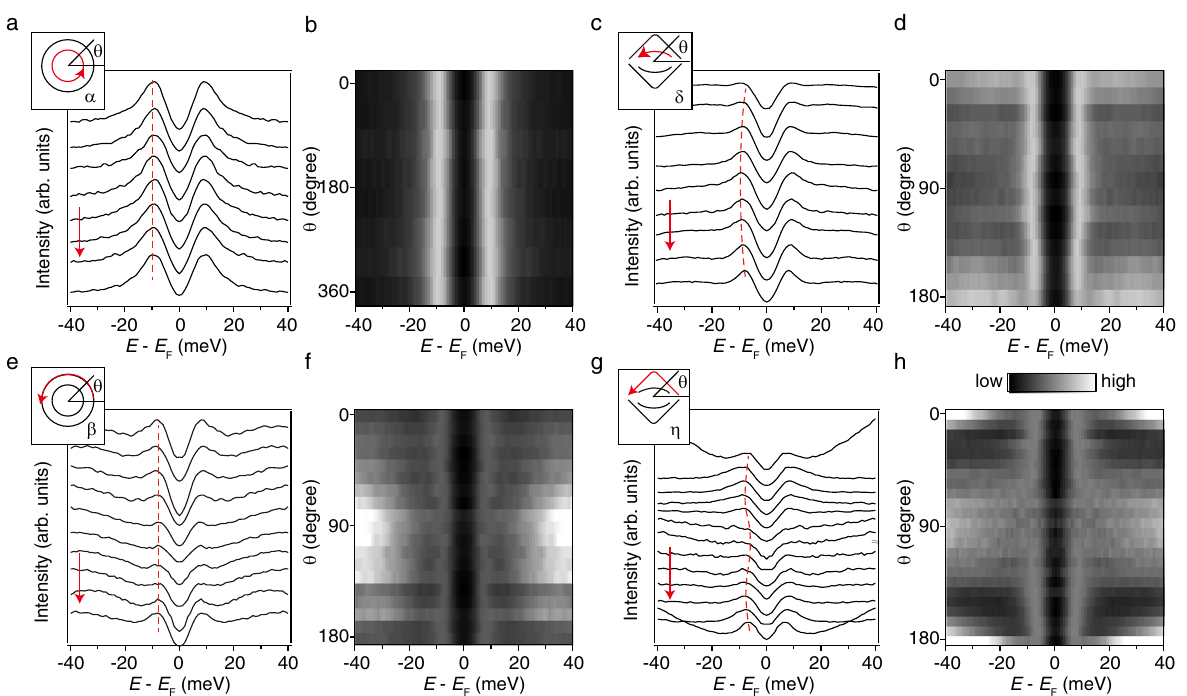
Fig. 3 Angular distributions of superconducting gap on Fermi surface sheets. a Angle dependence of the symmetrized energy distribution curves (EDCs) taken on the α hole pocket. The red dashed line guides the eyes to the gap anisotropy. E – E F represents the binding energy of electrons. E is the kinetic energy of electrons and E F is the Fermi energy. The red arrow illustrates the direction of the data presentation. b The merged image of the symmetrized EDCs for better visualizing the gap anisotropy. The polar angle ( θ ) is de fi ned in a . Panels c , d , e , f , g , and h are the same as a and b , but taken on the δ , β , and η pockets, respectively. All data were taken in the D3 sample at 8 K.